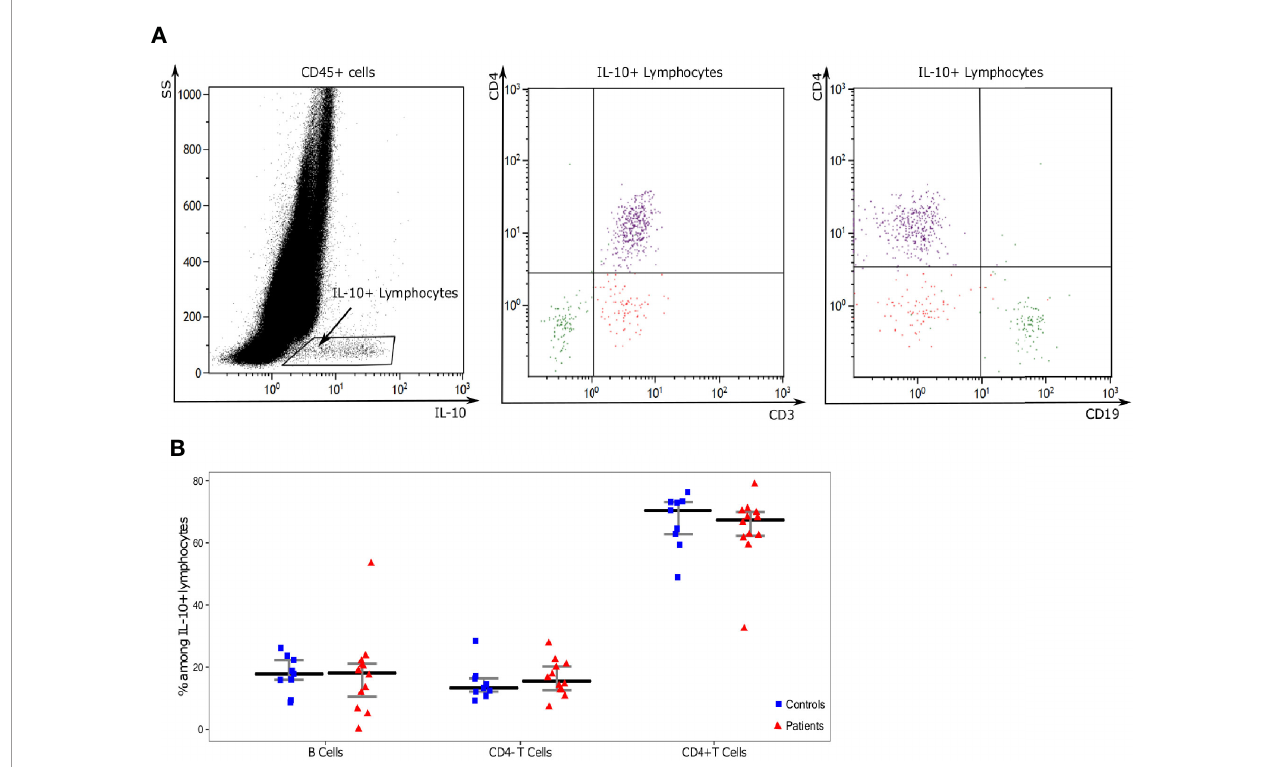
FIGURE 3 | Analysis of IL-10 producing lymphocytes. (A) One representative example of fl ow cytometry staining in a septic patient. First, on a IL-10 (x-axis) and SS (y-axis) dot-plot gated on in CD45+ leukocytes, we selected IL-10 producing lymphocytes (IL-10 + SSC low cells). CD3, CD19, and CD4 expressions were then characterized on these cells based on CD4 (y-axis) and CD3 or CD19 (x-axis) dot-plots. Three populations of IL-10 producing cells were identi fi ed: CD19+CD3-CD4- cells (Green: B lymphocytes), CD19-CD3+CD4+ cells (purple: CD4+ T cells), CD19-CD3+CD4+ cells (red: CD4- T cells). (B) Proportions of lymphocyte subsets